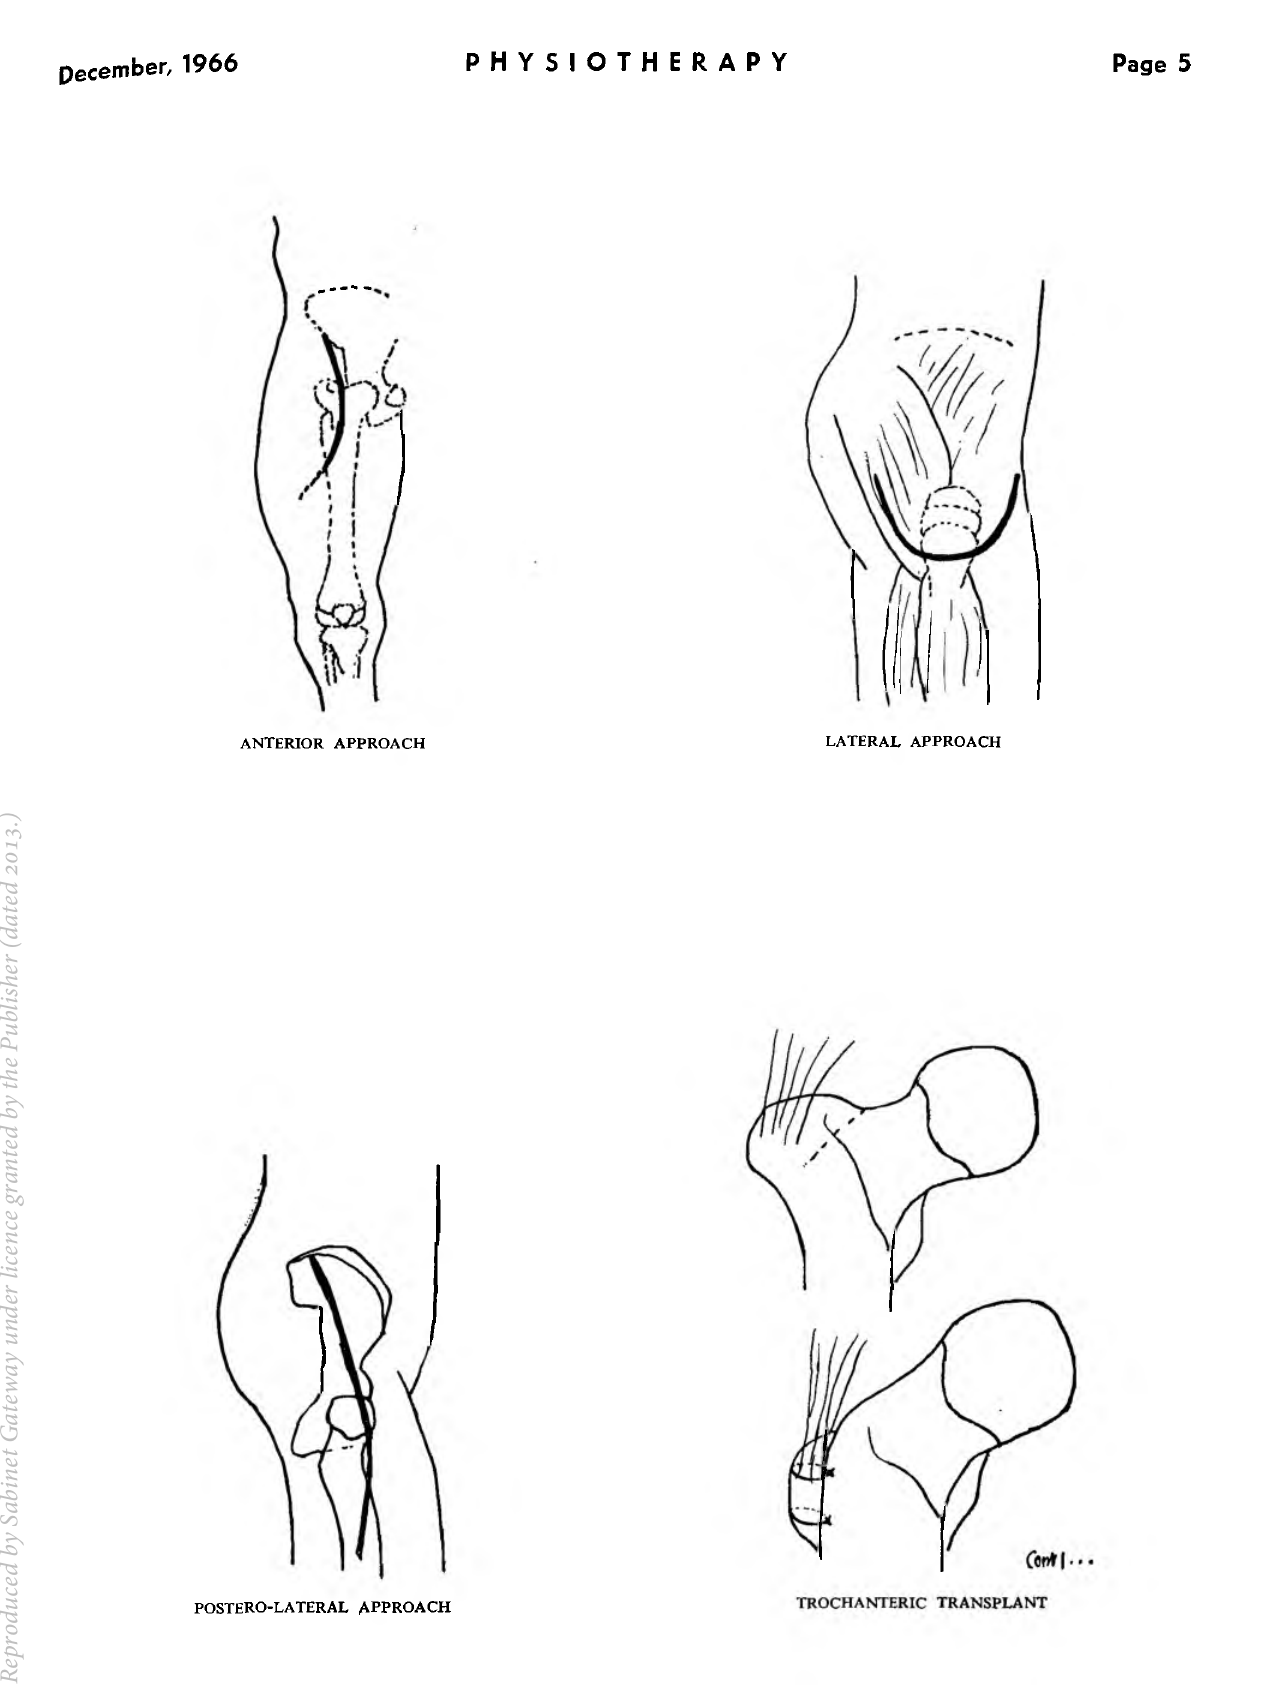
ANTERIOR APPROACH LATERAL APPROACH